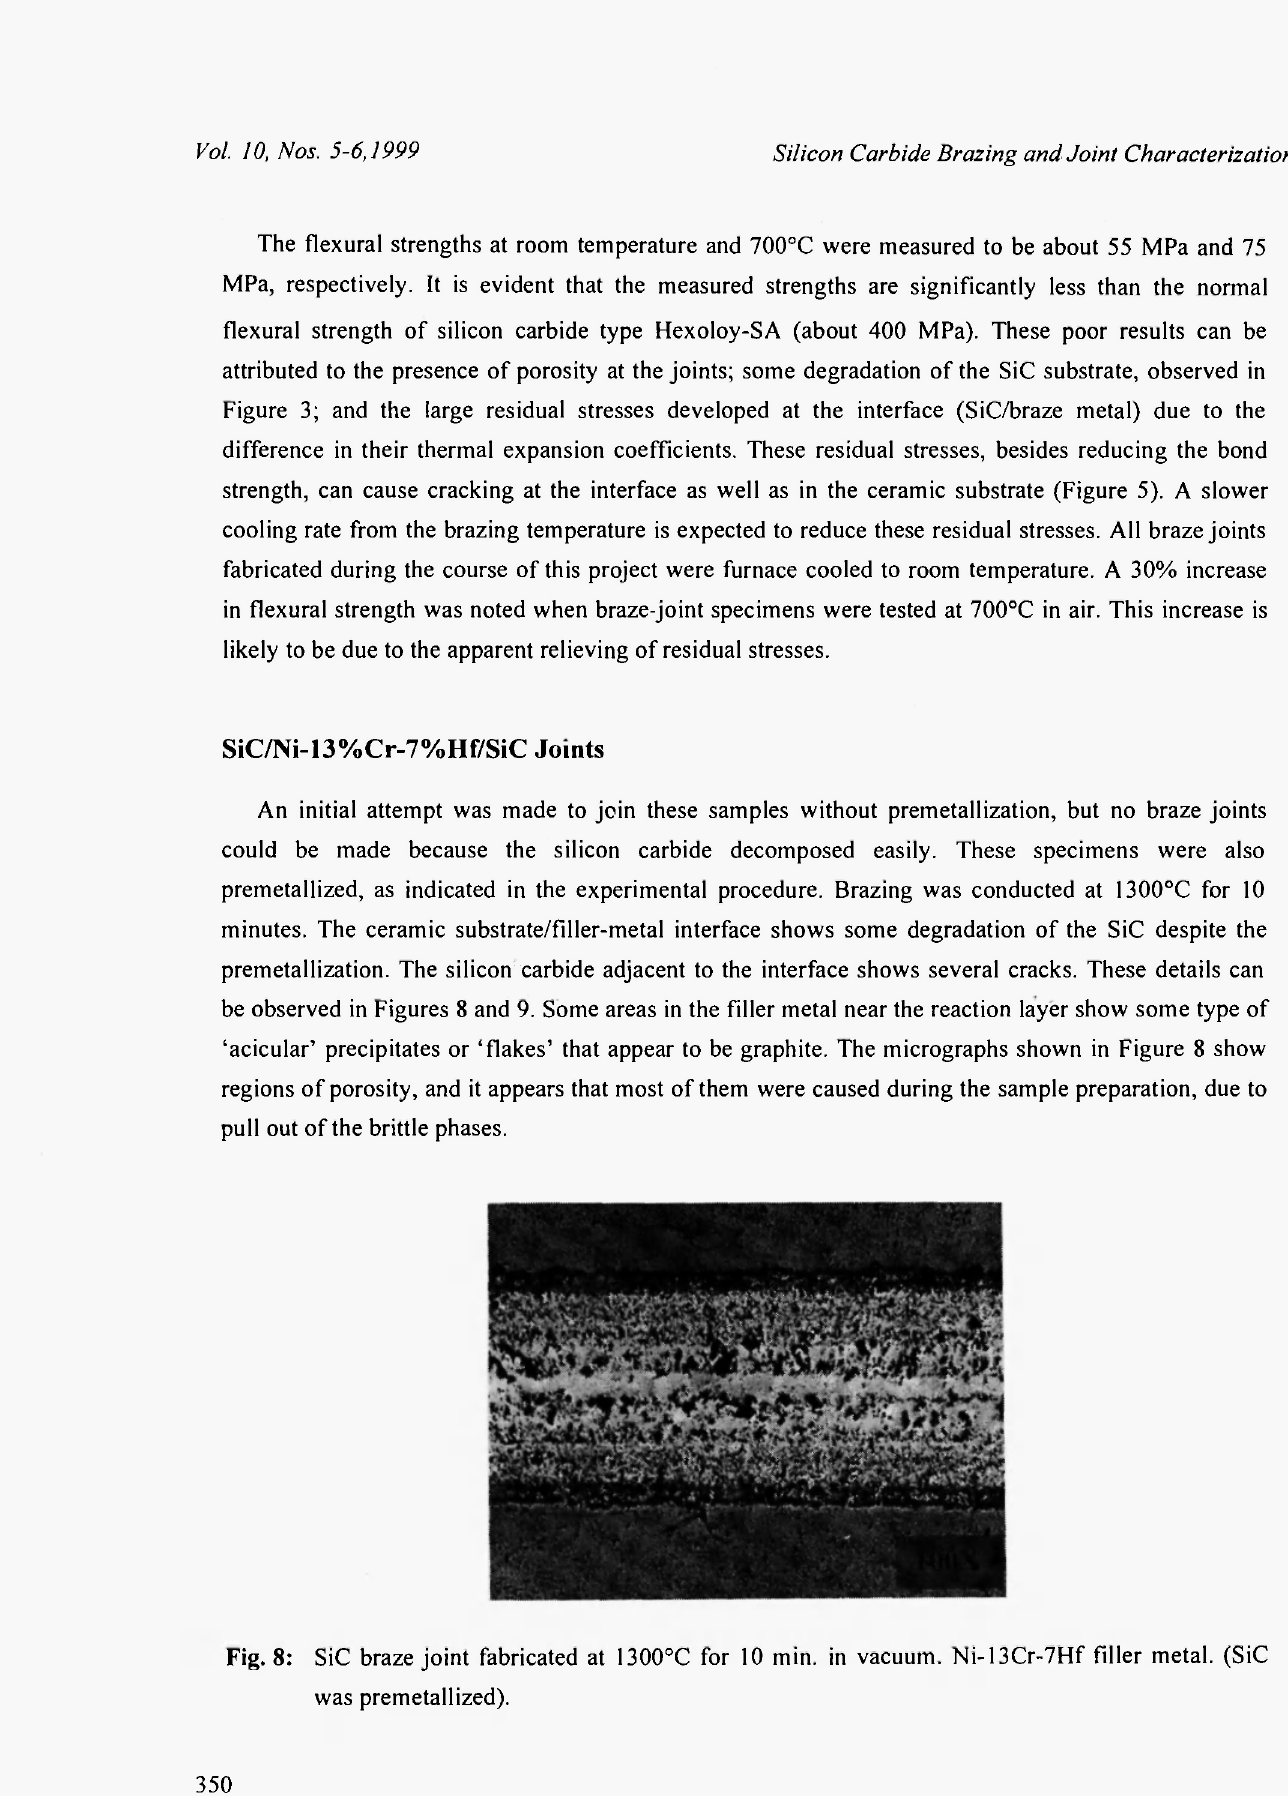
Fig. 8: SiC braze joint fabricated at 1300°C for 10 min. in vacuum. Ni-13Cr-7Hf filler metal. (SiC was